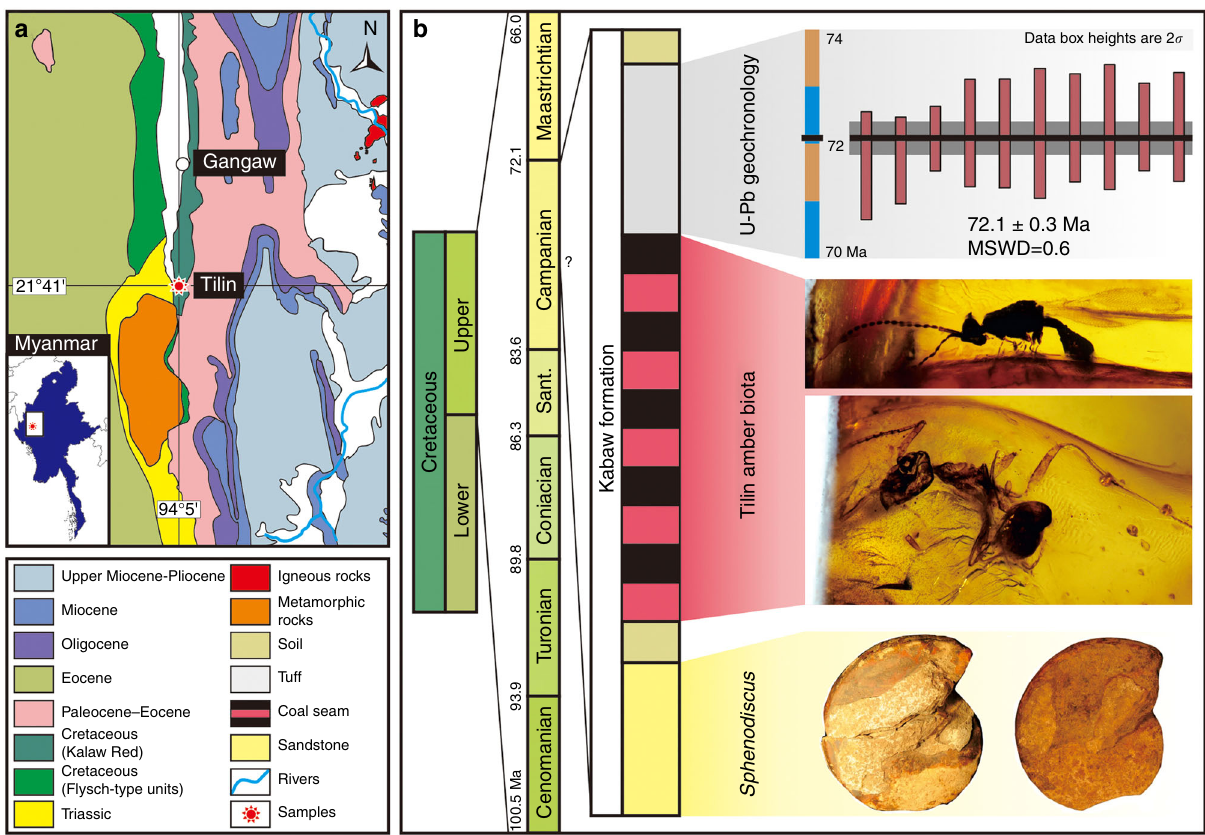
Fig. 1 Geology of Tilin amber. a Geological location of Tilin amber in Gangaw, central Myanmar. b Stratigraphic column showing lithologies, sample points, and age